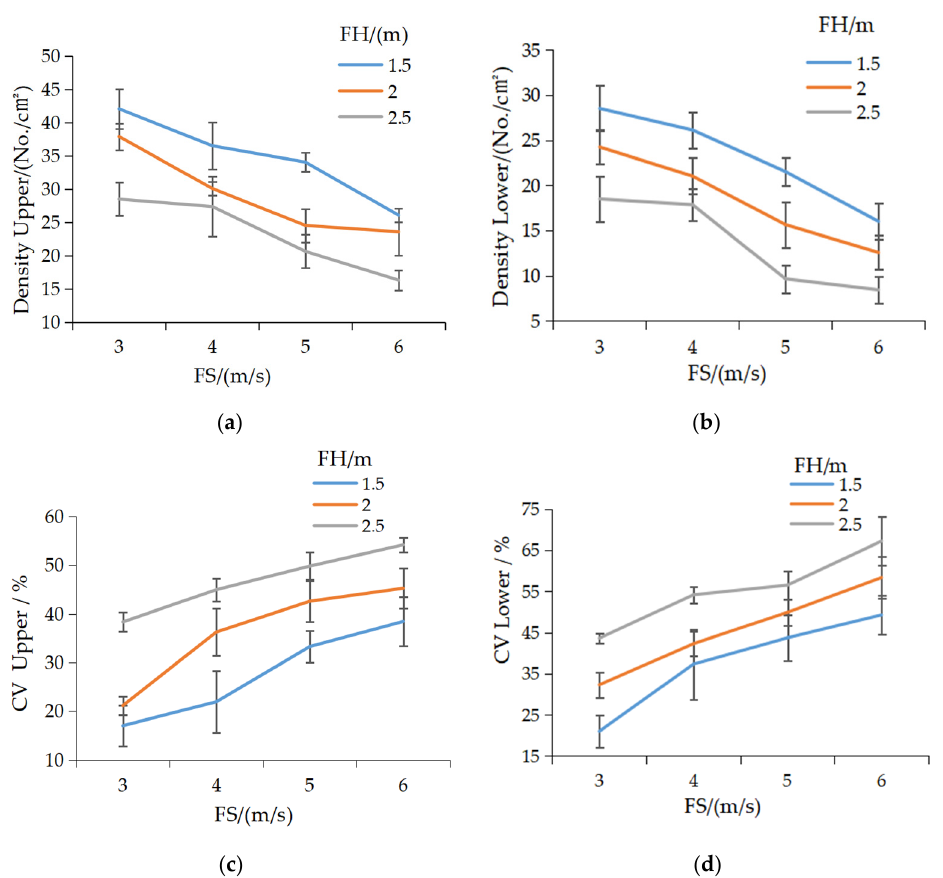
Figure 5. ( a ) Droplet coverage density in the upper layer; ( b ) droplet coverage density in the lower layer; ( c ) CV of droplet coverage density in the upper layer; ( d ) CV of droplet coverage density in the lower layer.